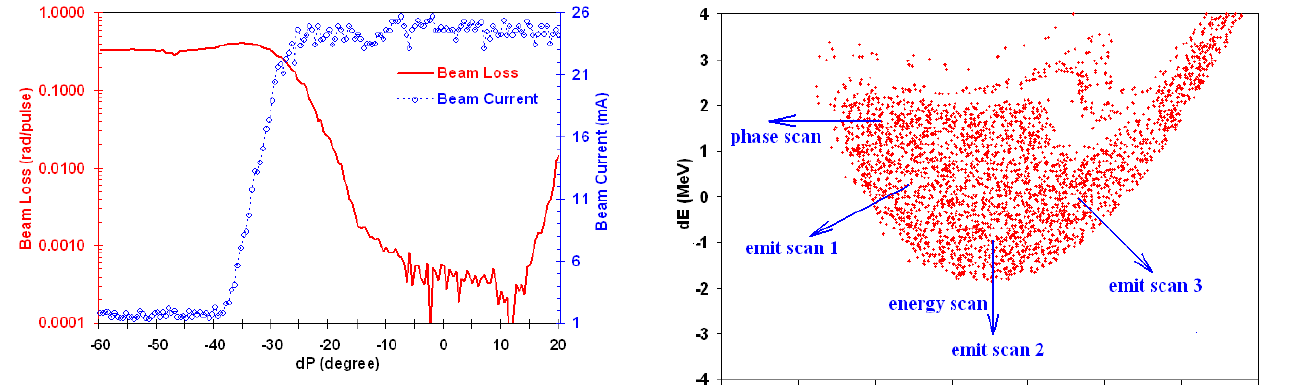
FIG. 8. (Color) The BCM signal measured in a beam phase scan, and the total beam loss measured with all BLMs. The design phase is 0.